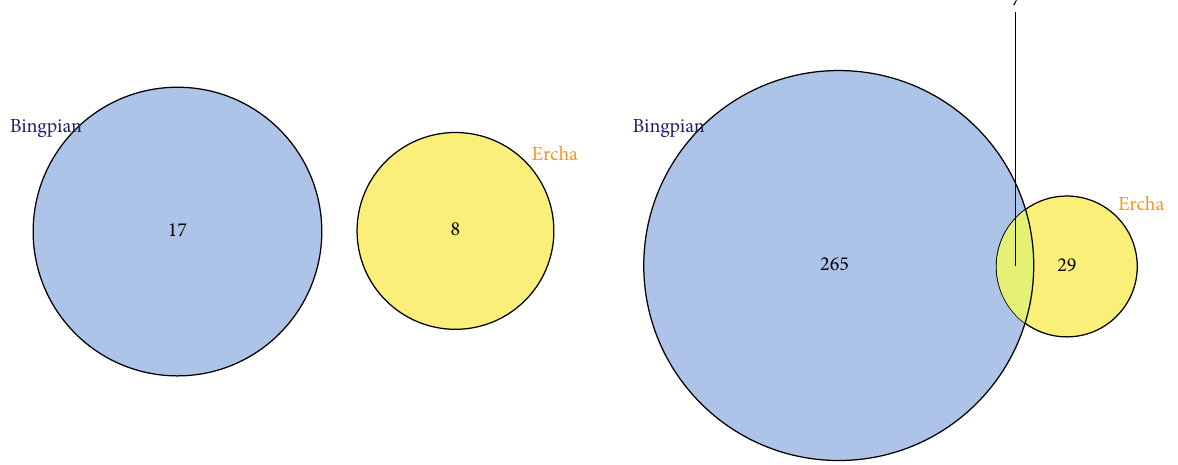
Figure 1: Interaction target intersection and union Venn